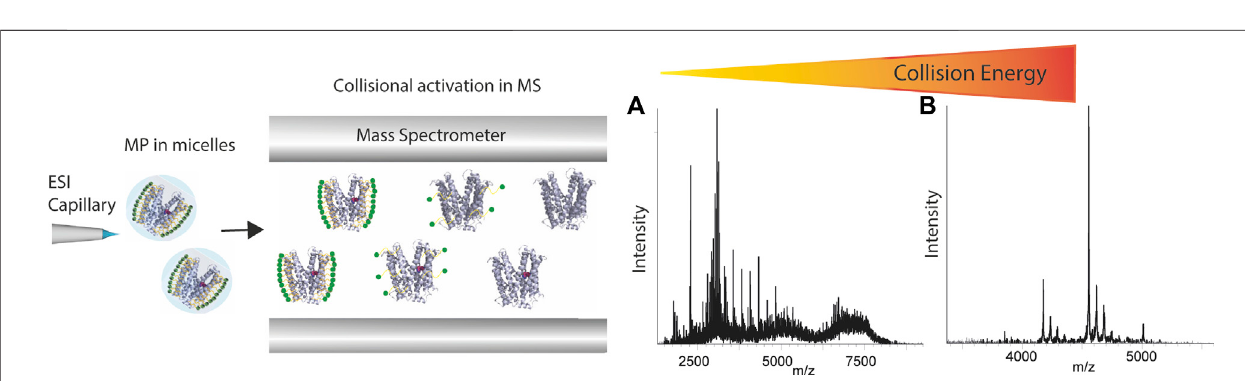
FIGURE 5 | Schematic representation of how membrane proteins are studied using native mass spectrometer. Proteins are fi rst desolvated and ionized, and then the micelle is removed inside the mass spectrometer applying high energies. The spectra show that with increasing collisional energy applied in the mass spectrometer, the spectrum can go from (A) micelle cluster dominated to (B) clear peaks representing the membrane